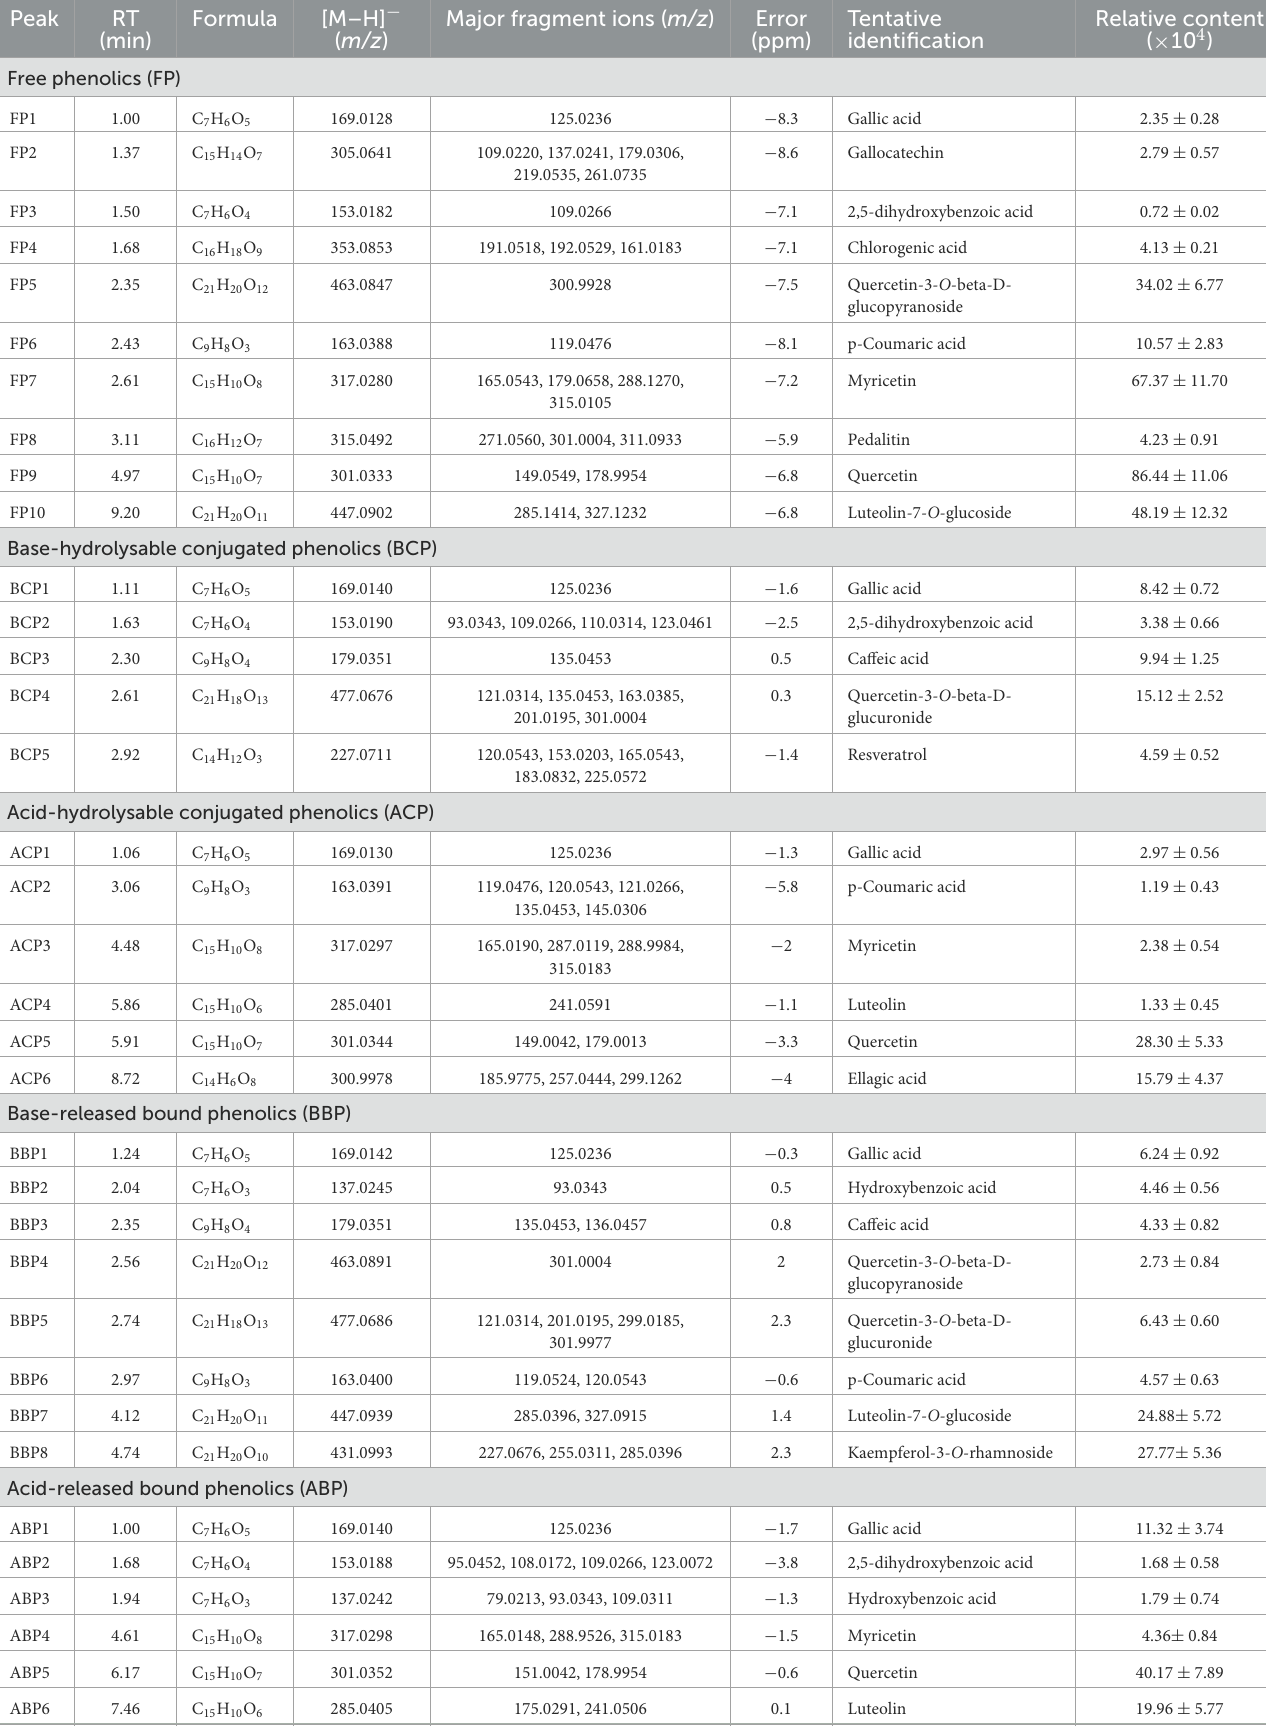
TABLE 1 Identification and relative content of individual phenolics in free, conjugated, and bound forms in hazel leaf.